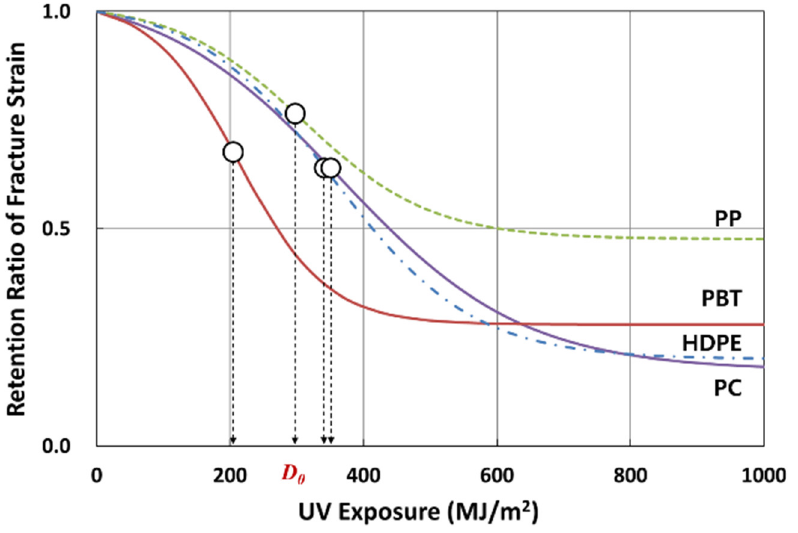
Figure 14. Comparison of fracture strain retention between PC, PP, PBT, and PE during 4-year weathering test. Midpoint positions ( D 0 , open circles) are shown for each polymer.